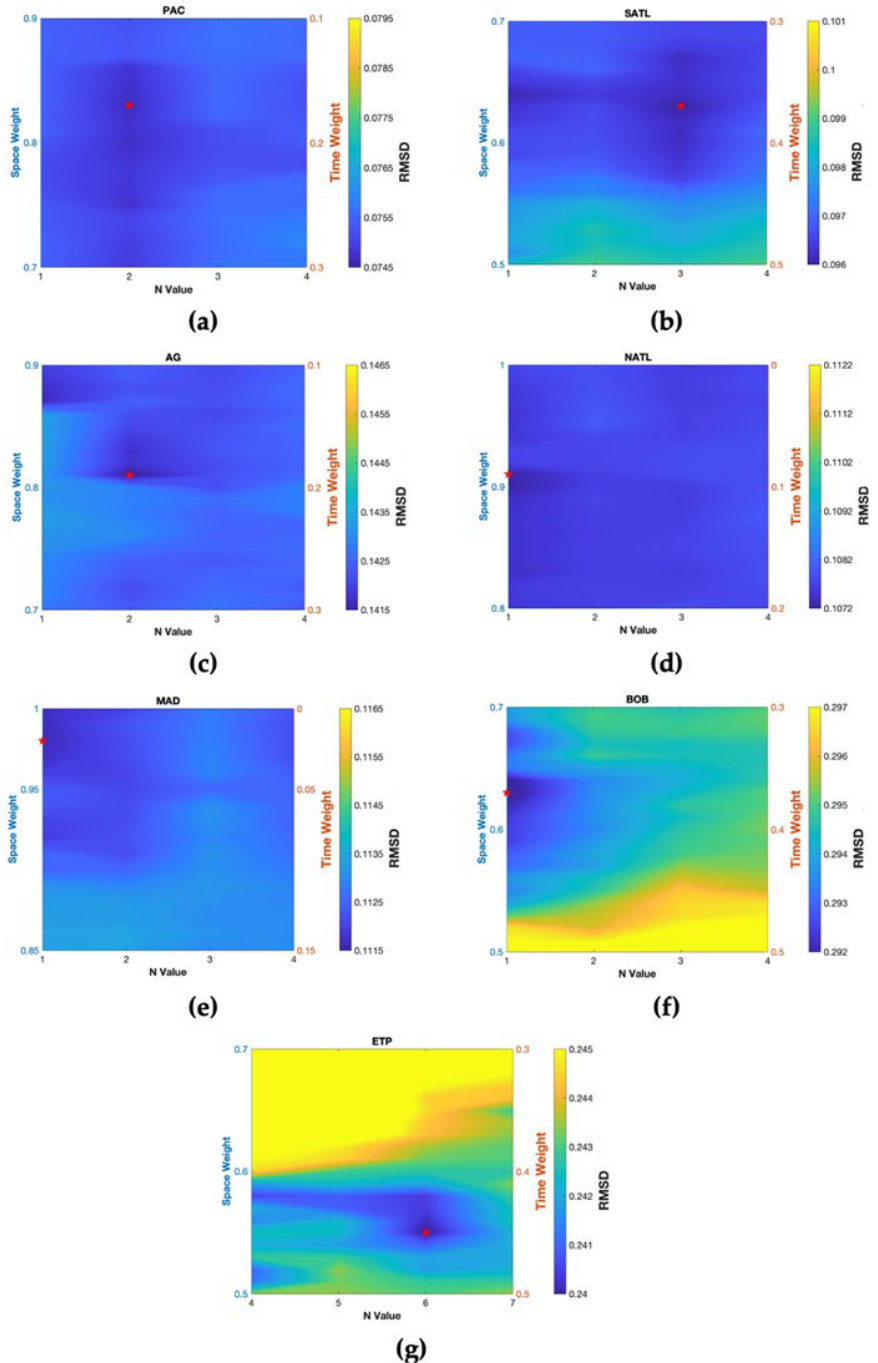
Figure 4. Contour plots of the RMSD generated by the Aquarius data set in each region using a range of N and space_weight values, shown on the X and Y axis. The N and space_weight combination that yielded the lowest RMS Difference is considered to be optimal for the region and is marked by a red star ( (cid:70) ). Only the four N values and 20 space_weight values that encompass the area with the lowest RMS Differences are shown for each region. The color scale is different for each plot, as RMSD was primarily influenced by location, but each color scale only includes a range of RMSD values 0.005 units long, so the variety of colors present reveals the level of importance of the optimization in each region. For the sake of brevity, contour plots for only Aquarius data are shown here. Similar plots for SMOS and SMAP data can be found in the Supplementary Information (Figures S1 and S2). ( a )